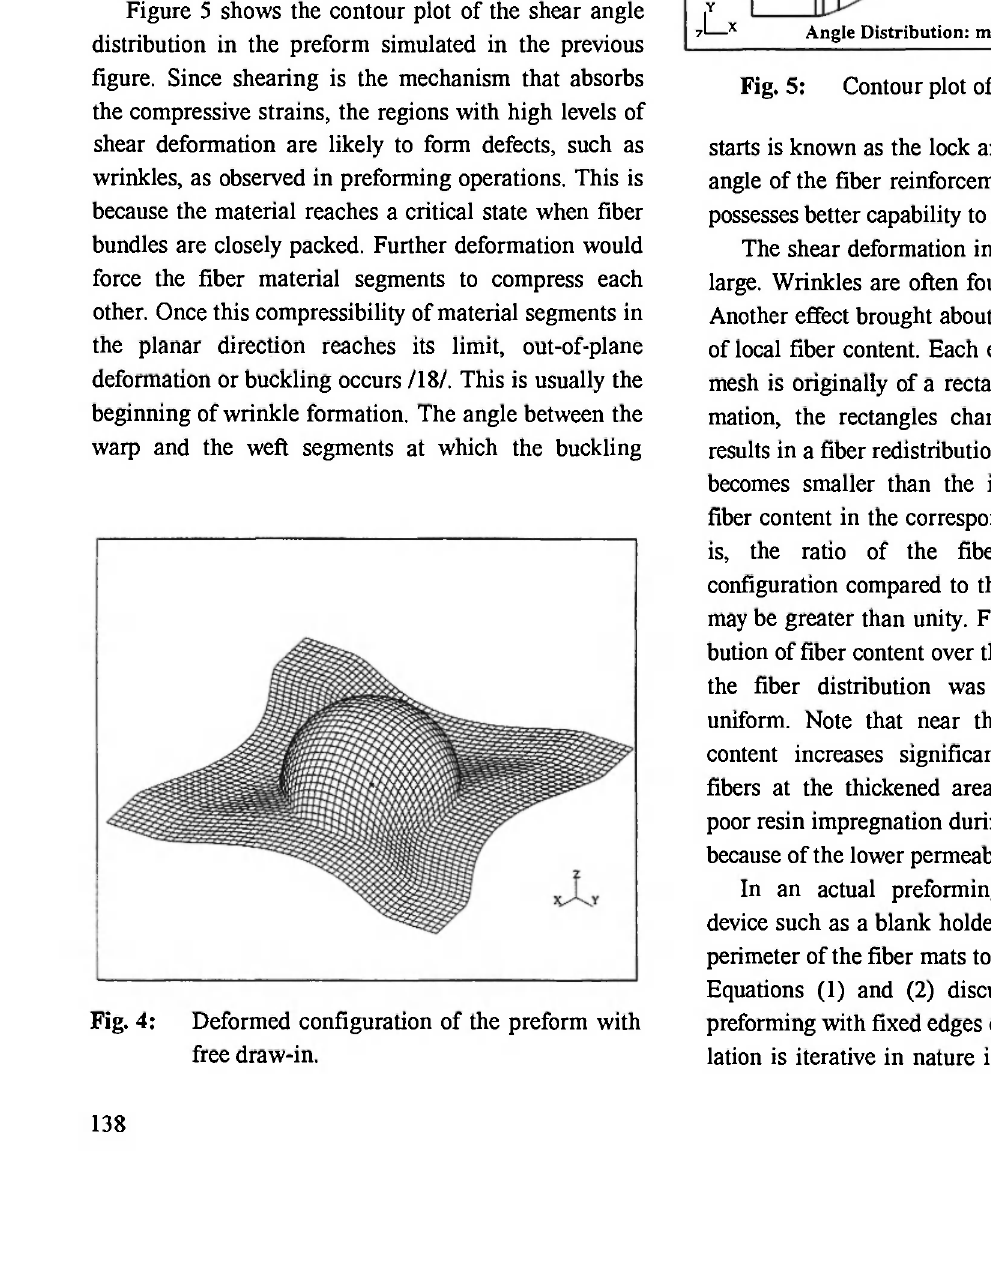
Fig. 4: Deformed configuration of the preform with free draw-in.